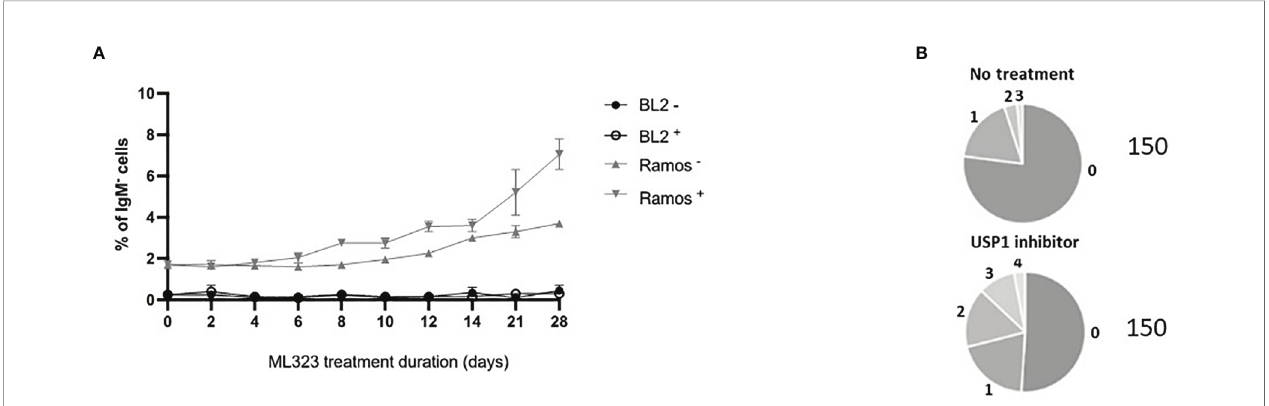
FIGURE 3 | Treatment of Ramos cells, but not BL2 cells, with a USP1 inhibitor increased IgM loss compared to that of nontreated cells. (A) Cells were treated with 10 m M ML323 (+) or DMSO ( – ), and the percentage of surface IgM was measured by FACS at the indicated time points. (B) Sequence analysis of SHM in the ampli fi ed Ramos VH region. Relative amounts of sequences with the indicated number of mutations (from 0 to 4) are given in the pie charts. The total number of analyzed sequences is indicated in the right of each chart and corresponds to the pool of the three experiments reported in Table 1 .